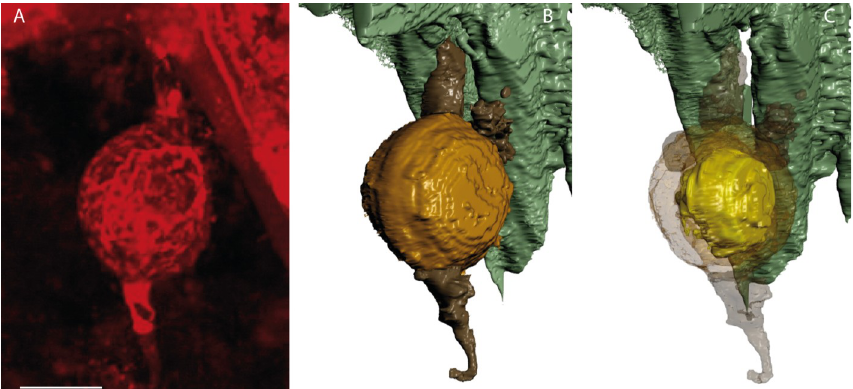
Fig 4. Three-dimensional reconstruction of an oogonium-antheridia complex of Oochytrium lepidodendri using confocal scanning laser microscopy (A) and CSLM images processed (B, C): the oospore becomes apparent by making the oogonial wall transparent (C) in the reconstruction (B). Two antheridia are attached to the oogonium possibly more (S1 Movie). No ornamentation is visible on the surface of the oogonium (B). Oogonium in light brown, antheridia in dark brown (B), oosphere in yellow (C) Scale bar represents 6.5 μ m in (A). MNHN.F.45876.0 n˚1146 Renault collection.